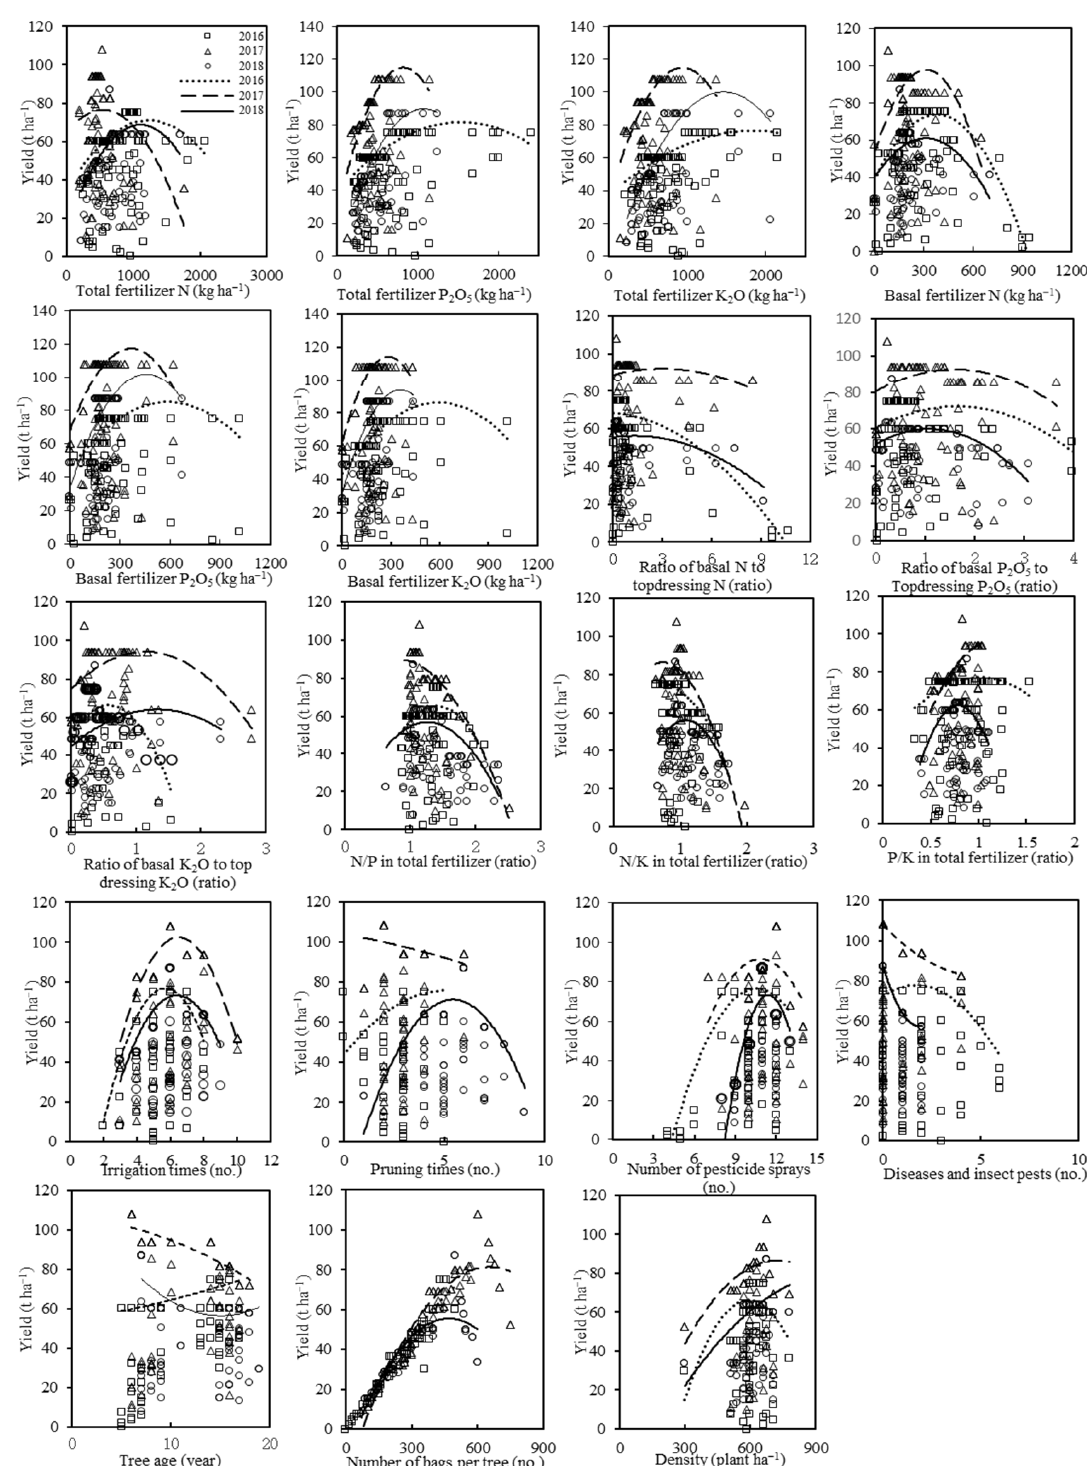
Figure 5. Relationships between apple yield and the main management factors limiting production in 2016–2018 for Beiquan Village, Hebei, China, as predicted by boundary line analysis. The dotted black line represents the boundary line of 2016, the dashed black line represents the boundary line of 2017, and the solid black line represents the boundary line of 2018.